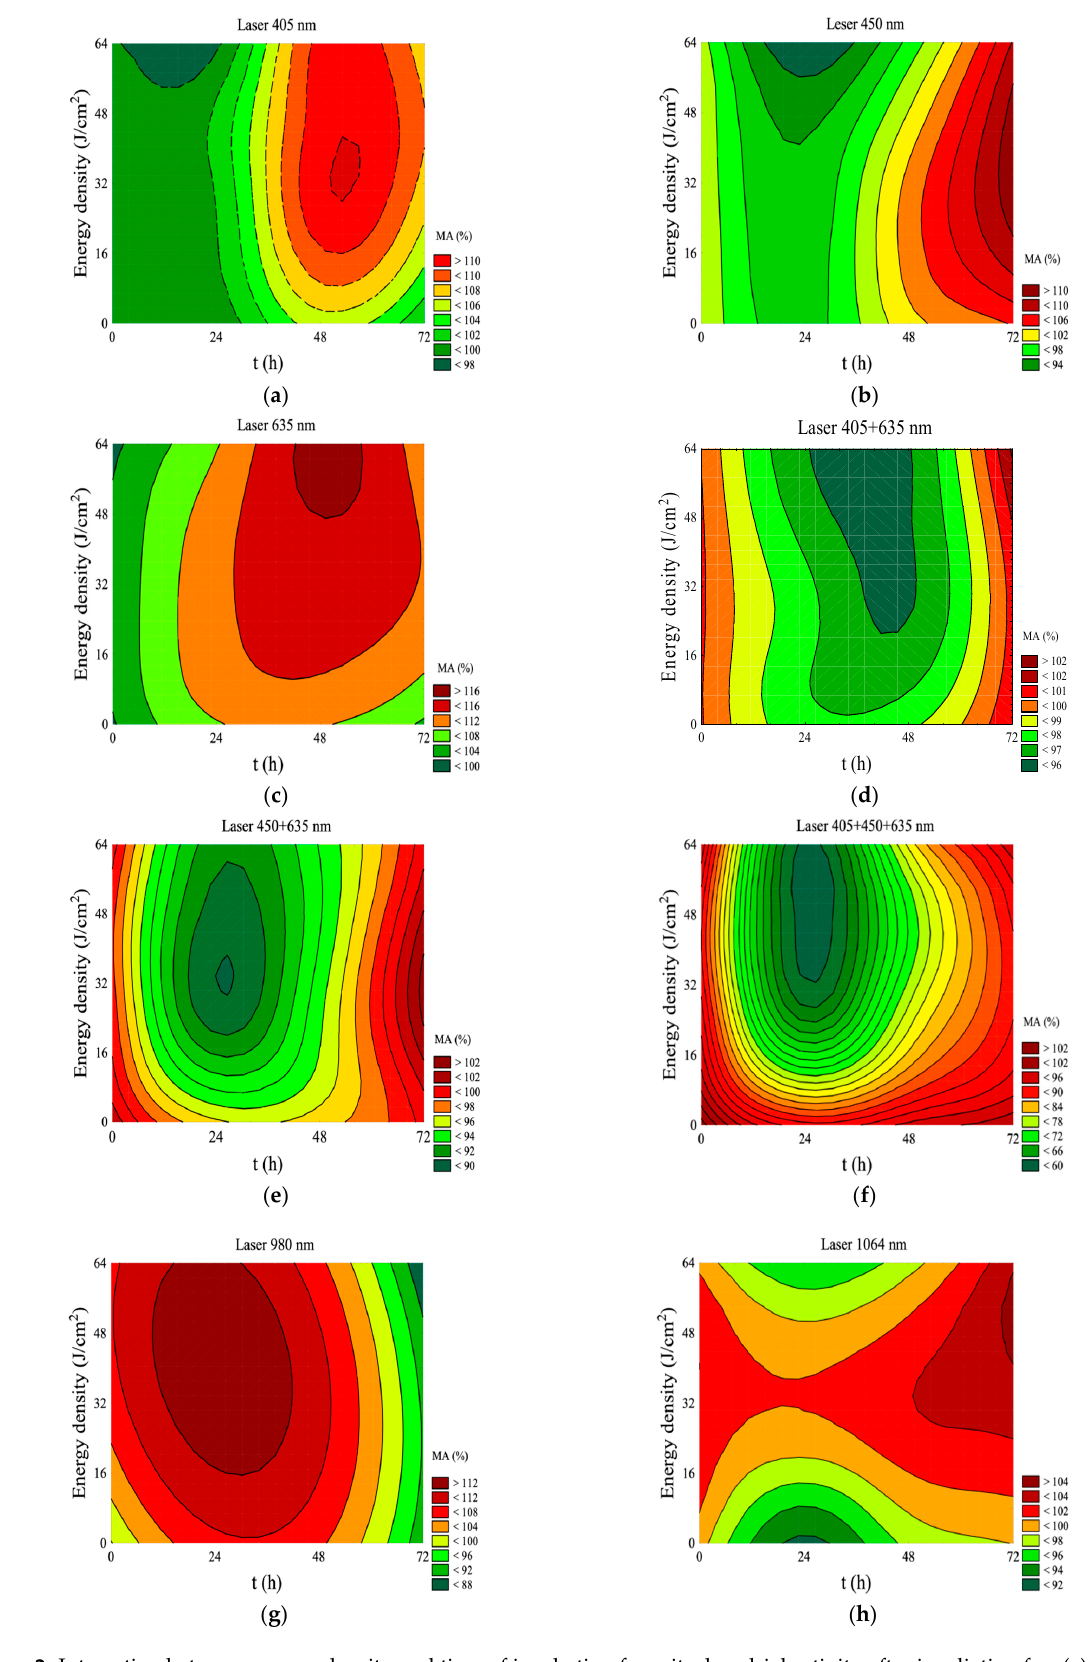
Figure 2. Interaction between energy density and time of incubation for mitochondrial activity after irradiation for: ( a ) 405 nm, ( b ) 450 nm, ( c ) 635 nm, ( d ) 405 + 635 nm, ( e ) 450 + 635 nm, ( f ) 405 + 450 + 635 nm, ( g ) 980 nm, ( h ) 1064 nm.